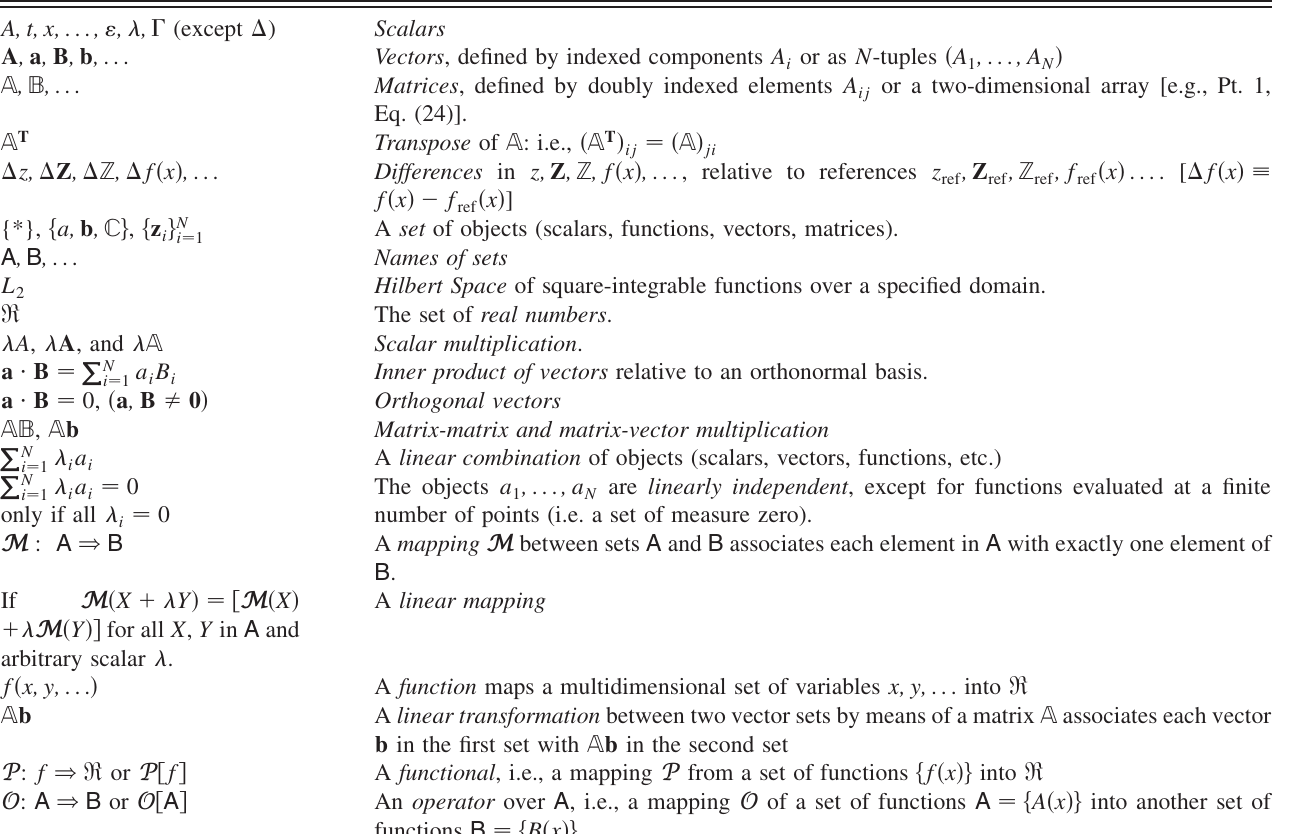
TABLE I. Definitions and mathematical notations. All mathematical quantities considered in this article are real valued